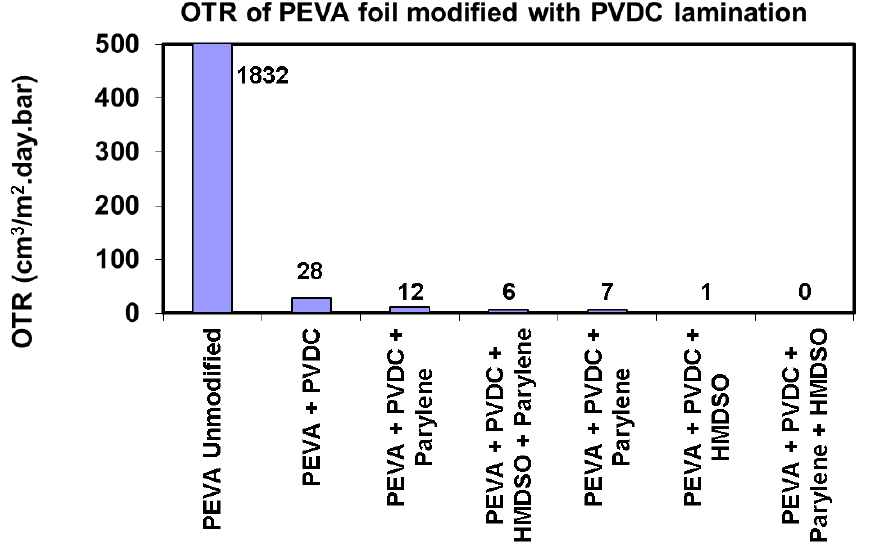
Figure 5. Oxygen permeation values detected for PEVA foil with barrier layers of PVDC, plasma polymerized HMDSO and parylene.